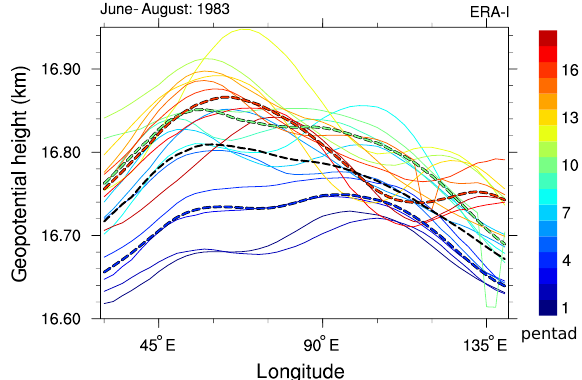
Figure 9. Geopotential height (km) along the ridgeline of the SAH for individual pentads (colour-coded solid lines) in 1983. The first pentad is 3–7 June 1983. Dashed lines show geopotential height along the ridgeline based on June (blue), July (green), August (red) and the seasonal (JJA) mean data (black) in